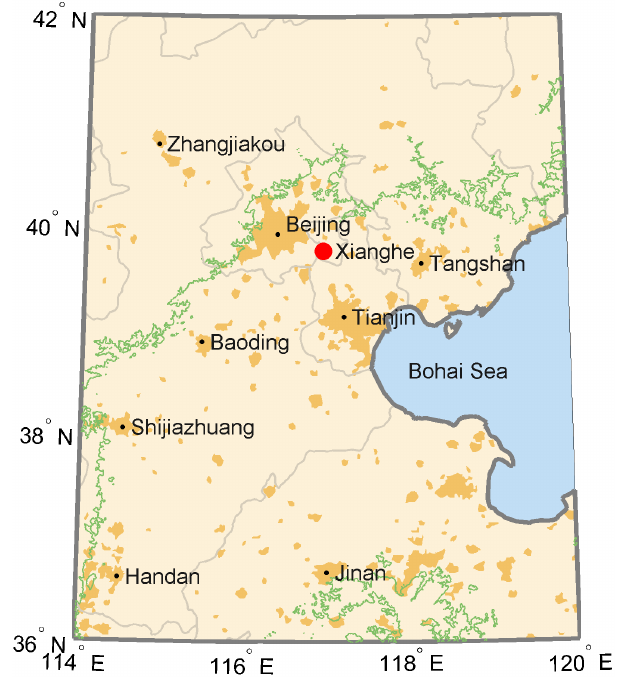
Figure 1. Map of the North China Plain. The observational site is marked as a red point. Urban areas are marked in yellow. The green line denotes the contour line of 500ma.s.l., which can be consid- ered as the natural boundary of the